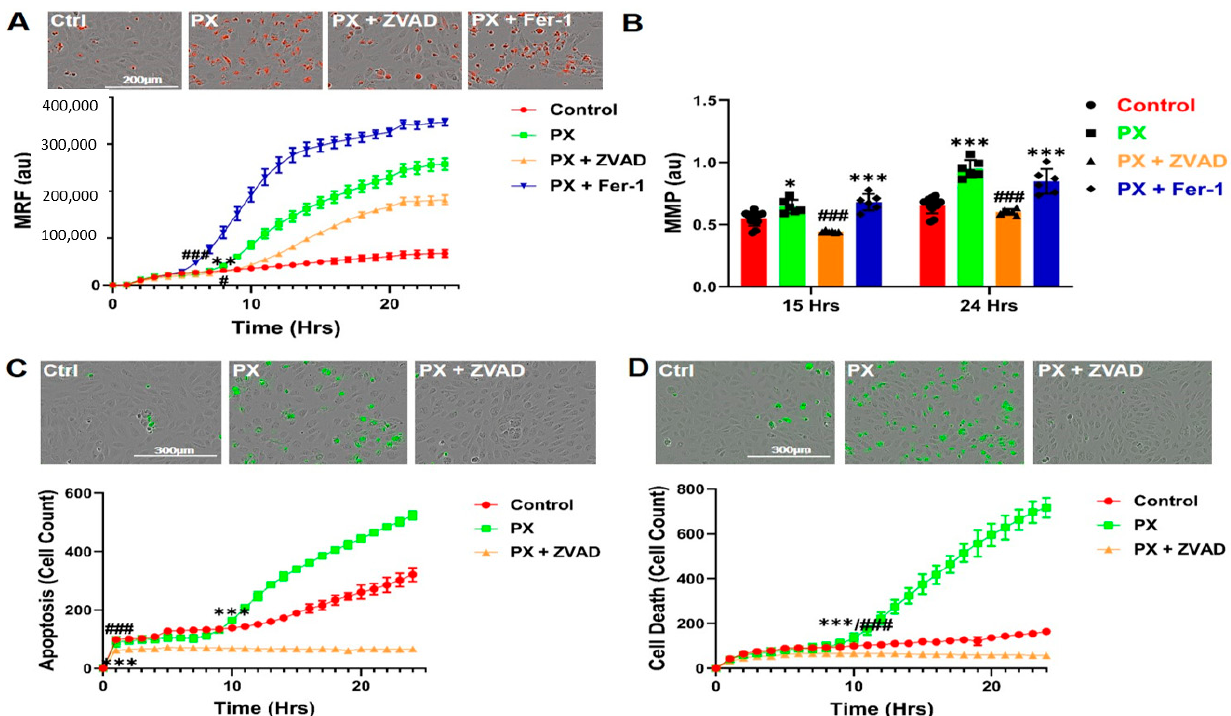
Figure 2. Apoptosis and mitochondrial stress are not a direct result of the early lipid peroxidation initiated by PX. ( A ) Live cell imaging of mitochondrial ROS formation was measured 24-h post 400 µM PX treatment on a BLEC monolayer. ZVAD and Fer-1 were added at 50 µM. Ctrl are cells cultured with normal medium without the addition of any treatments. Mean ± s.d. of one representative experiment is shown, out of three independent experiments with n = 12–18, ** p < 0.01 vs. ctrl and # p < 0.05 and ### p < 0.001 vs. PX marks the first time point with a significant change; ( B ) Mitochondrial membrane permeability was examined by measuring its membrane depolarization with JC-1 staining over a 24-h period on a PX treated BLEC monolayer. Mean ± s.d. of one representative experiment is shown, out of three independent experiments with n = 12–18, * p < 0.05 and *** p < 0.001 vs. ctrl and ### p < 0.001 vs. PX; ( C ) Apoptosis was measured with a caspase-3 activated fluorescent marker by live cell imaging 24-h post PX treatment on a BLEC monolayer. ZVAD was added at 50 µM. Mean ± s.d. of one representative experiment is shown, out of three independent experiments with n = 9–12, *** p < 0.001 vs. ctrl and ### p < 0.001 vs. PX marks the first time point with a significant change; ( D ) Live cell imaging of cell death was examined by cytotoxicity fluorescent staining over a 24-h period on a PX treated BLEC monolayer. Mean ± s.d. of one representative experiment is shown, out of three independent experiments with n = 12–18, *** p < 0.001 vs. ctrl and ### p < 0.001 vs. PX marks the first time point with a significant change. Ctrl, control; PX, paraoxon; ZVAD, Z-VAD-FMK; Fer-1, Ferrostatin; MRF, mitochondrial ROS formation; MMP, mitochondrial membrane permeability; au, arbitrary units. 3.3. The Iron Chelator DFO Rescues Both Cell Viability and Functionality Since several ROS processes were evident in our model, but had no direct effect on BBB integrity, we wanted to elucidate the effect of DFO in our model since it rescued BLEC from PX-induced cell death (Figure 1B). Indeed, DFO rescued cytotoxicity throughout the 24-h window (Figure 3A). Since DFO is an iron chelator, we hypothesized that damage to BLEC deregulated the cellular iron homeostasis. Indeed, PX increased the labile iron pool within the cell, while DFO moderately but significantly rescued this effect (Figure 3B). Unlike Fer-1, DFO did not rescue the cells exclusively through the ferroptosis-like process since it also significantly decreased apoptosis (Figure 3C). Since apoptosis was inhibited, we next measured the effect of DFO on mitochondrial membrane permeation, a hallmark of the apoptosis pathway [68]. Conversely, DFO exacerbated the damage to the mitochon- drial membrane (Figure 3D), suggesting that DFO did not affect apoptosis through the classic chain of events that are associated with the breakdown of the mitochondrial mem- brane. We next measured the cellular ROS formation since the Fenton reaction is a cata- lytic process in which iron is oxidized by hydrogen peroxide, a product of mitochondrial oxidative respiration, ultimately leading to the creation of a highly toxic hydroxyl free